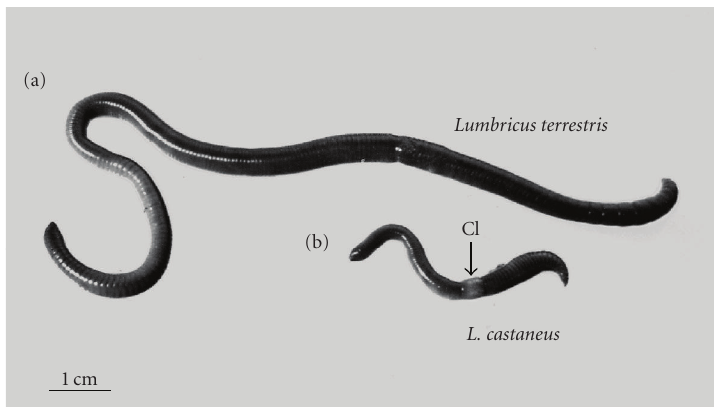
Figure 4: Photograph of two German earthworm species that inhabit grasslands, but occupy di ff erent ecological niches. Lumbricus terrestris (a), a burrowing (anecic) species, and L. castaneus (b), an epigeic earthworm. The swollen clitellum (Cl) of the sexually mature L. castaneus is